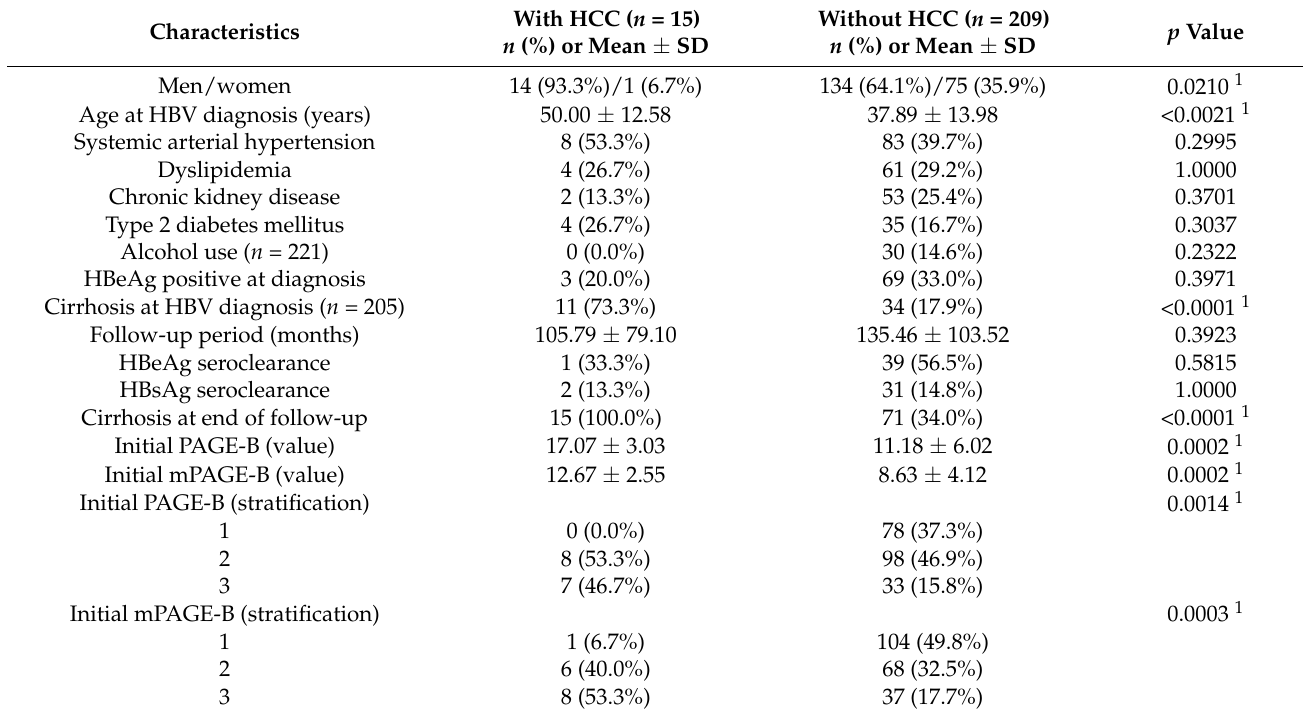
Table 2. Factors associated with HCC occurrence ( n = 224).